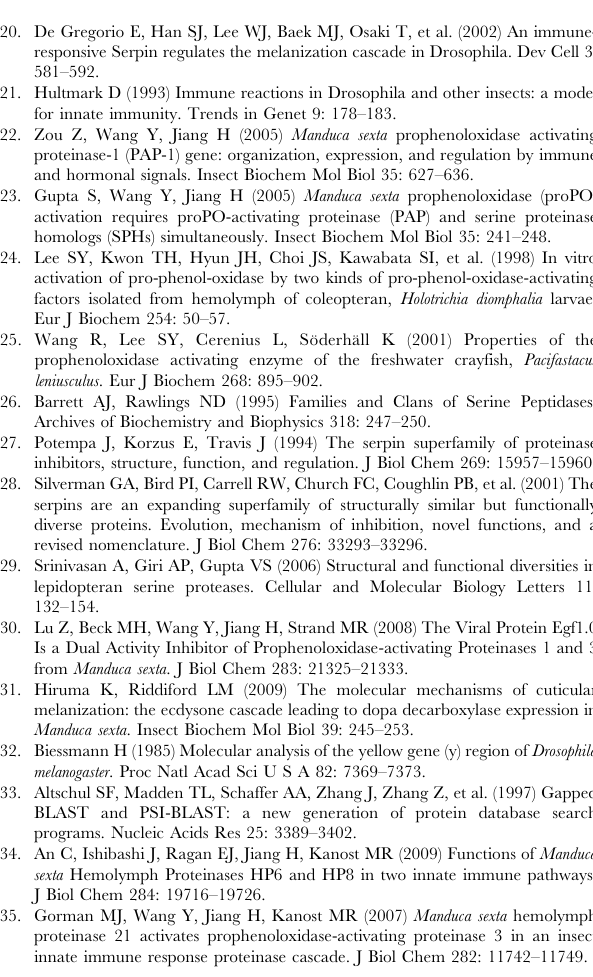
Table S1 Table of polymorphisms used to genotype the melanisation candidates.